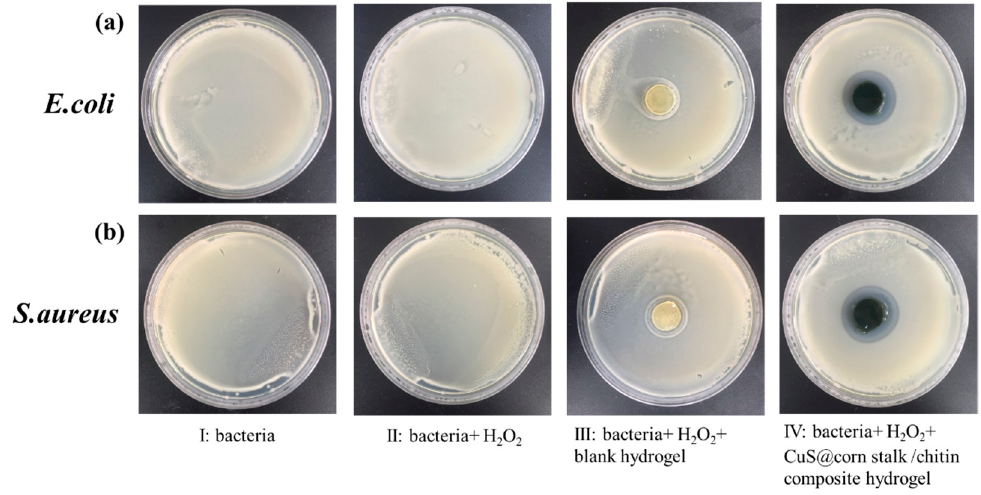
Figure 6. Photos of culture results of different bacterial solutions. ( a ) and ( b ) represent E. coli and S. aureus , respectively. I: Bacteria; II: Bacteria + H 2 O 2 ; III: Bacteria + H 2 O 2 + blank hydrogel; IV: Bacteria + H 2 O 2 + CuS@corn stalk/chitin composite hydrogel.